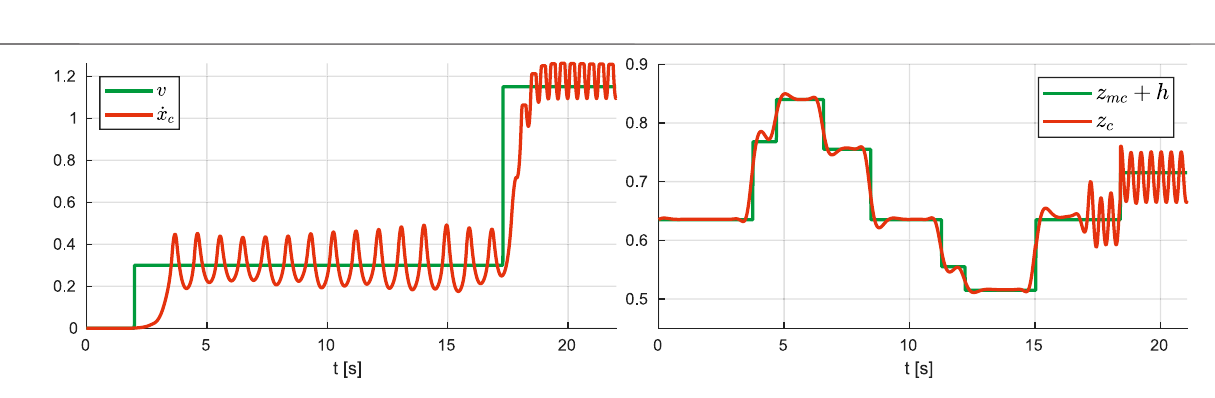
FIGURE 14 | Walking and running in a world of stairs: reference and actual sagittal velocity (left), reference and actual CoM height (right).